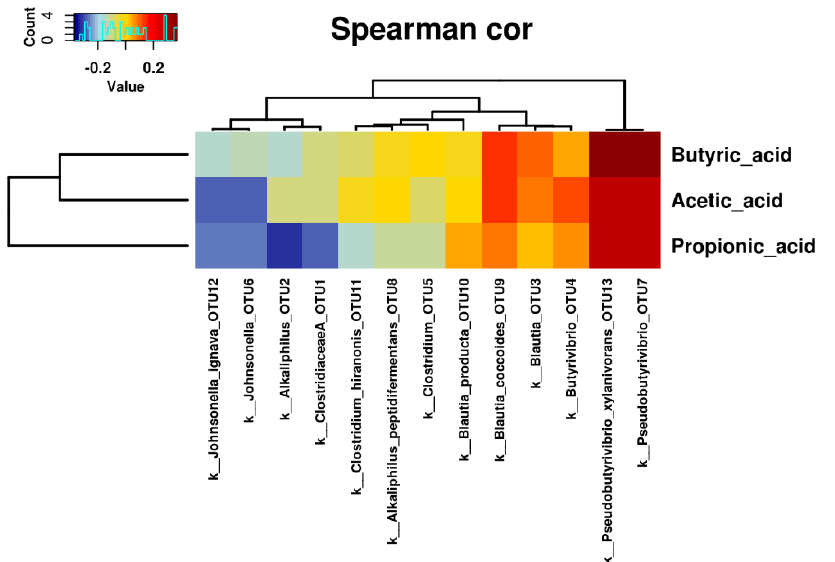
Figure 3. Heatmap representation of correlation coefficients between SCFA concentrations and gut microbiota composition. Only taxa with significantly different abundance in both beer consumption groups were included.